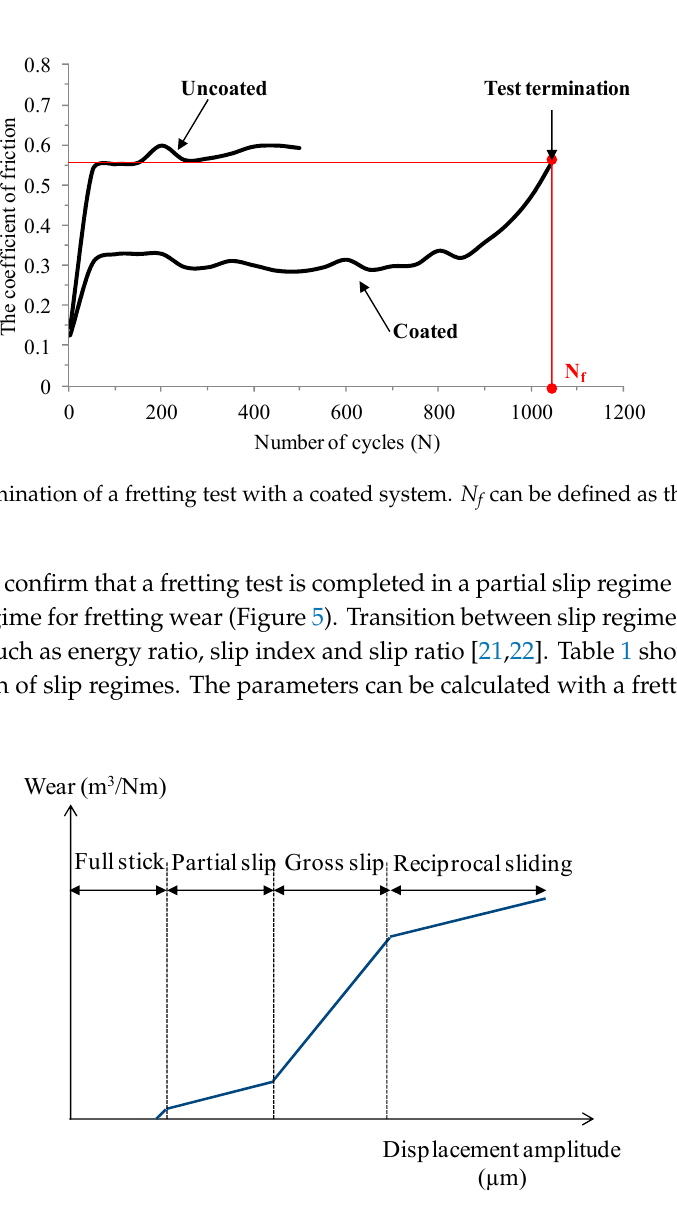
Figure 5. Wear rate according to displacement amplitude. Redrawn with permission from [2] . Table 1. Direct comparison of the parameters used for identification of slip regimes. P denote a normal